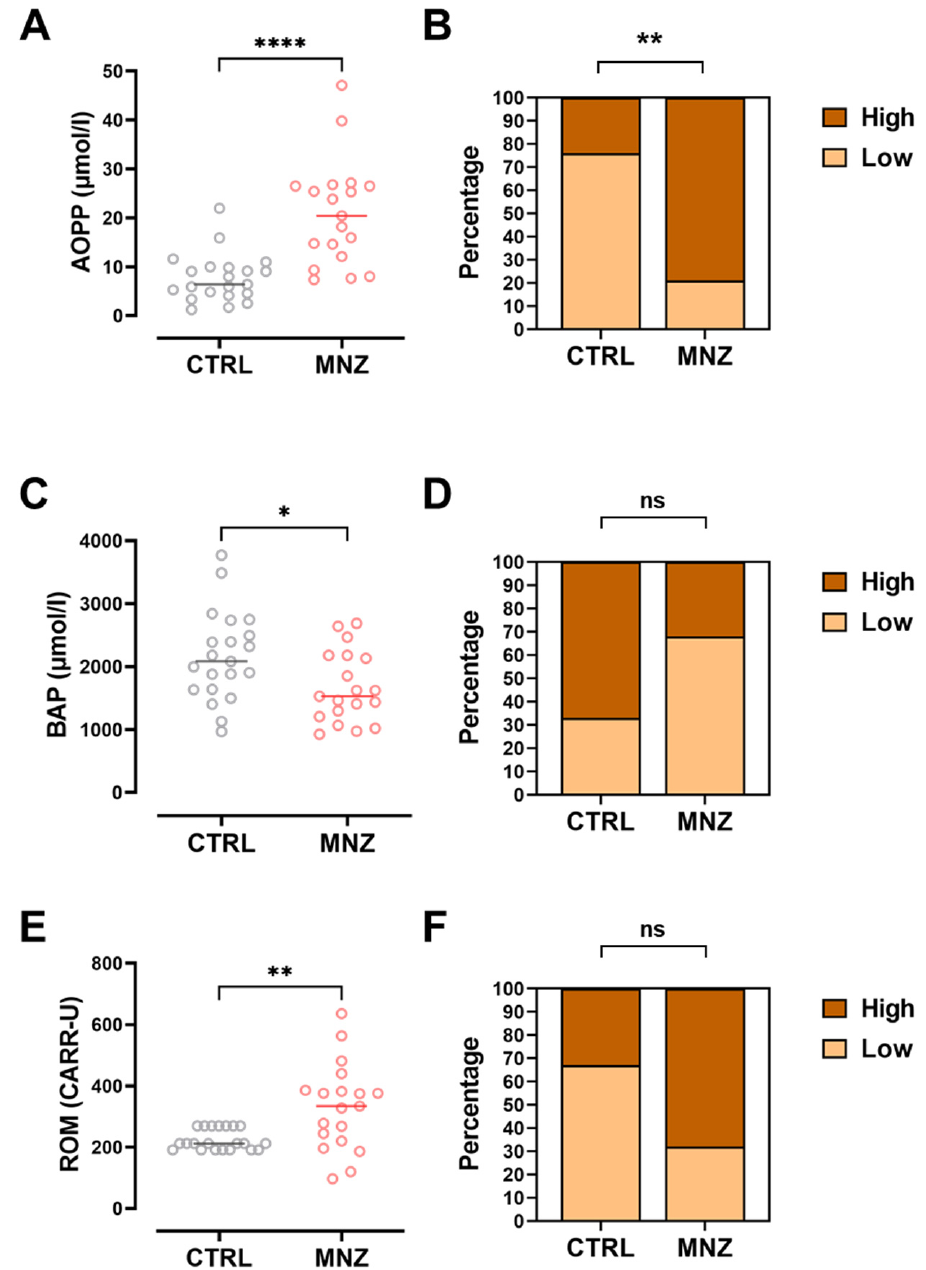
Figure 5. Oxidative stress serum biomarker assessment in MNZ-exposed greenhouse workers compared with non-exposed control population. ( A ) AOPP levels (expressed in μ mol/L) in control non-exposed (CTRL) and MNZ-exposed (MNZ) workers. ( B ) Contingency analysis for AOPP expression (percentage of samples with high versus low marker expression, cutoff median value, 9.99 μ mol/L). ( C ) BAP levels (expressed in μ mol/L) in CTRL and MNZ workers. ( D ) Contingency analysis for BAP expression (percentage of samples with high versus low marker expression, cutoff value the median, 1881.54 μ mol/L). ( E ) ROM levels (expressed in CARR-U) in CTRL and MNZ workers. ( F ) Contingency analysis for ROM expression (percentage of samples with high versus low marker expression, cutoff value the median, 256.50 CARR-U). ( A , C , E ) Grey circles, controls non-exposed, CTRL; red circles, mancozeb-exposed, MNZ. In ( A , C , E ) data are reported as dot plots with median values. For group comparisons, either Mann–Whitney tests or unpaired t tests were used, according to the distribution of data. * p < 0.05; ** p < 0.01; **** p < 0.0001; ns = not significant. Specifically, in MNZ-exposed individuals and non-exposed controls, median AOPP serum levels were 20.4 and 6.4 μ mol/L, respectively ( p < 0.0001), and median ROM serum levels were 334 and 212 CARR-U, respectively ( p = 0.0018). In line with these results, BAP serum levels were 1529 and 2084 μ mol/L ( p = 0.020), respectively, in MNZ-exposed individuals and non-exposed controls. To evaluate the predictive value of such differences, contingency analyses with Fisher exact test were conducted, demonstrating that specifically AOPP levels measurement in serum might additionally have a significant predictive value (Figure 5B,D,F; p = 0.0012).